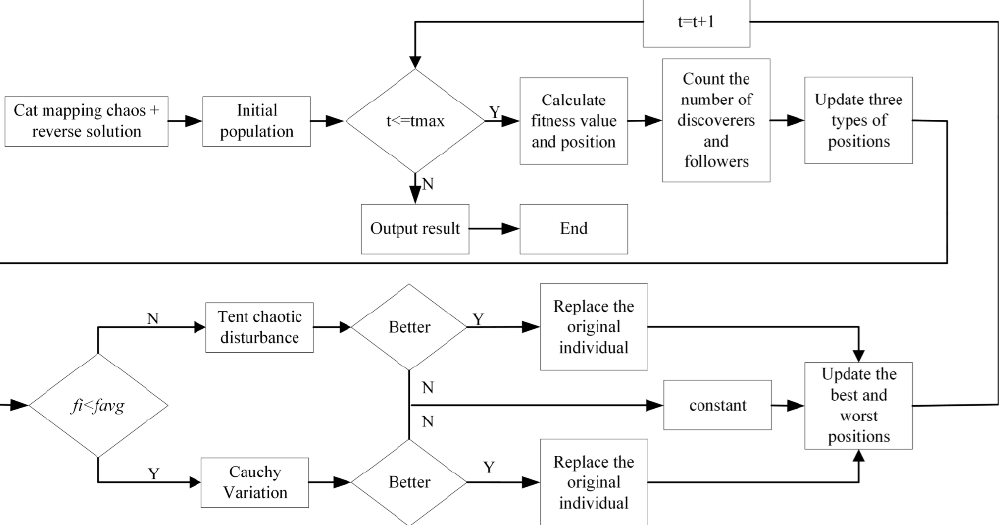
Figure 6. AMSSA algorithm flow chart. fi means the fitness value of the population individuals and favg means the average fitness value of the population individuals.